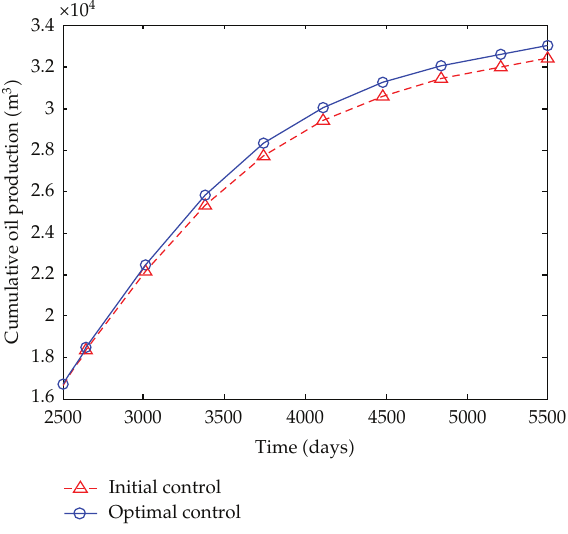
Figure 9: Cumulative oil